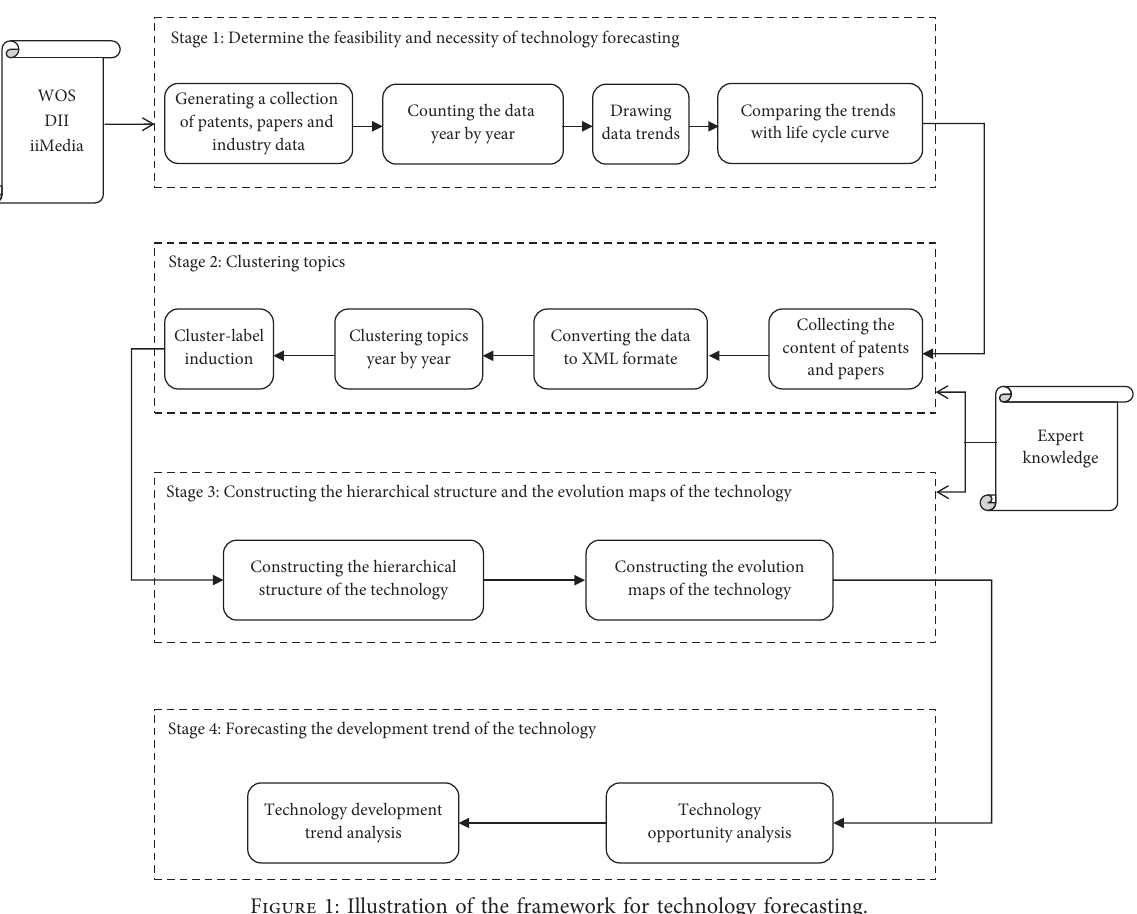
Figure 1: Illustration of the framework for technology